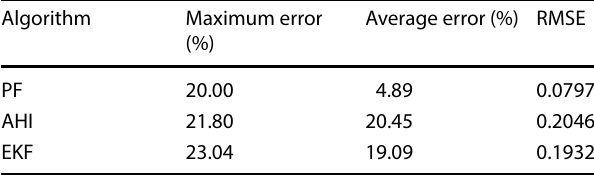
Table2 Estimation error of SOC with initial value of 0.8